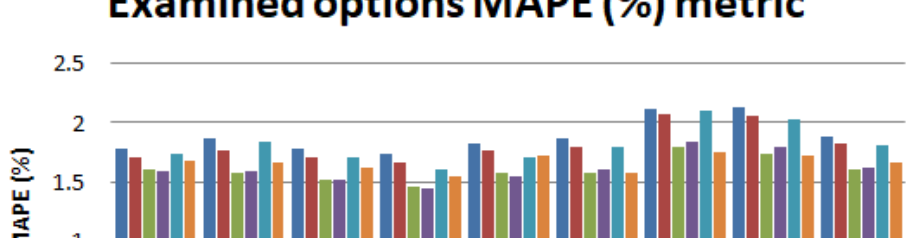
Figure 7. Mean absolute percentage error (MAPE) (%) metric results for examined options (period January–August 2018).